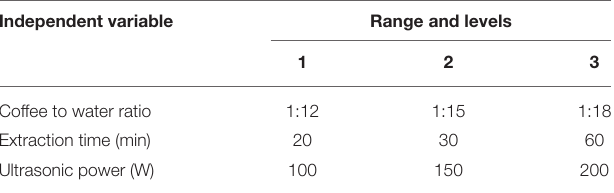
TABLE 1 | Factors and levels of OED L 9 (3 3 )